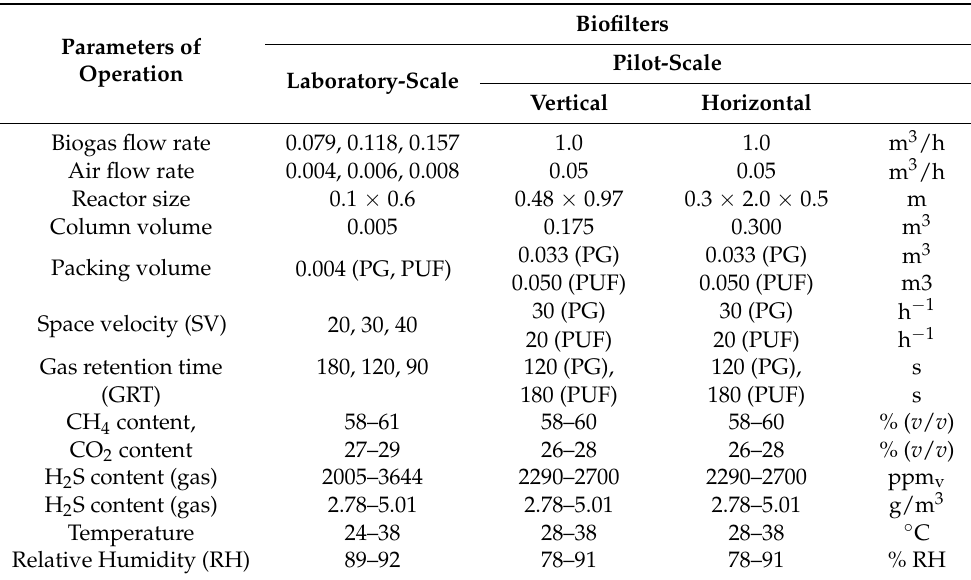
Figure 1. The schematic diagram of the ( a ) laboratory- and ( b ) pilot-scale biofiltration systems. Table 1. Operating parameters of the laboratory- and pilot-scale